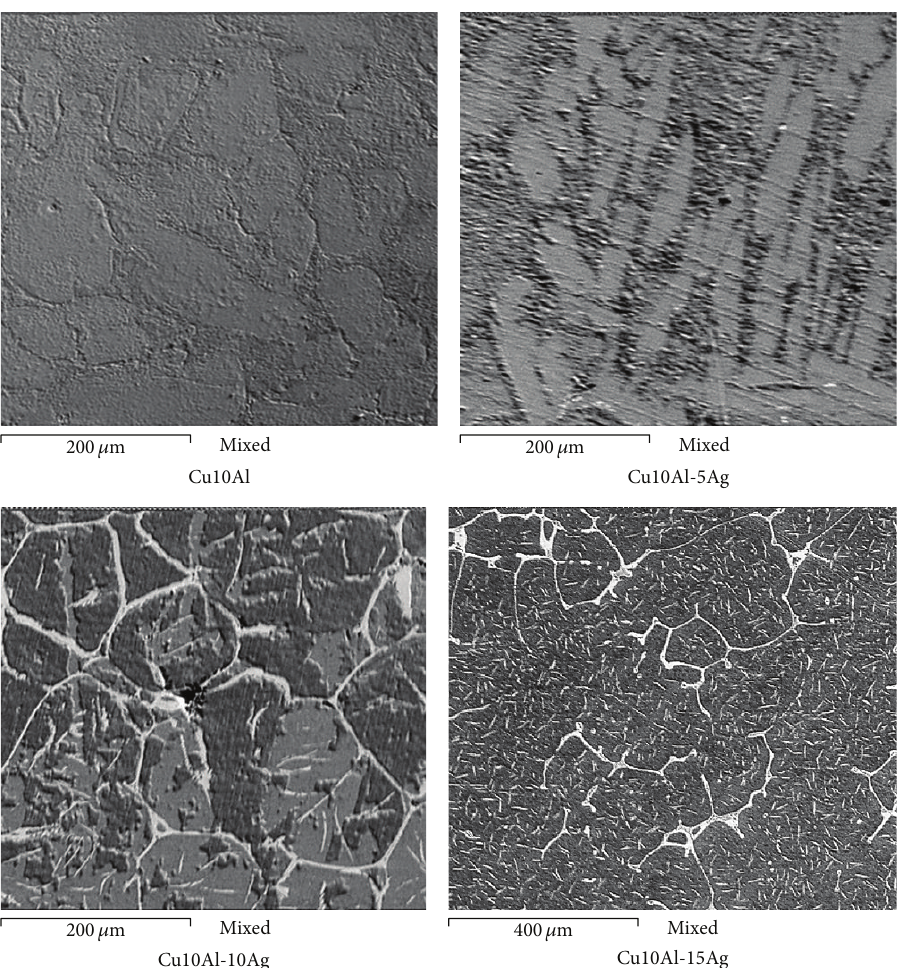
Figure 10: Superficial aspect of the Cu10Al- 𝑥 Ag alloys after the corrosion test in artificial saliva at 37 ∘ C for 48